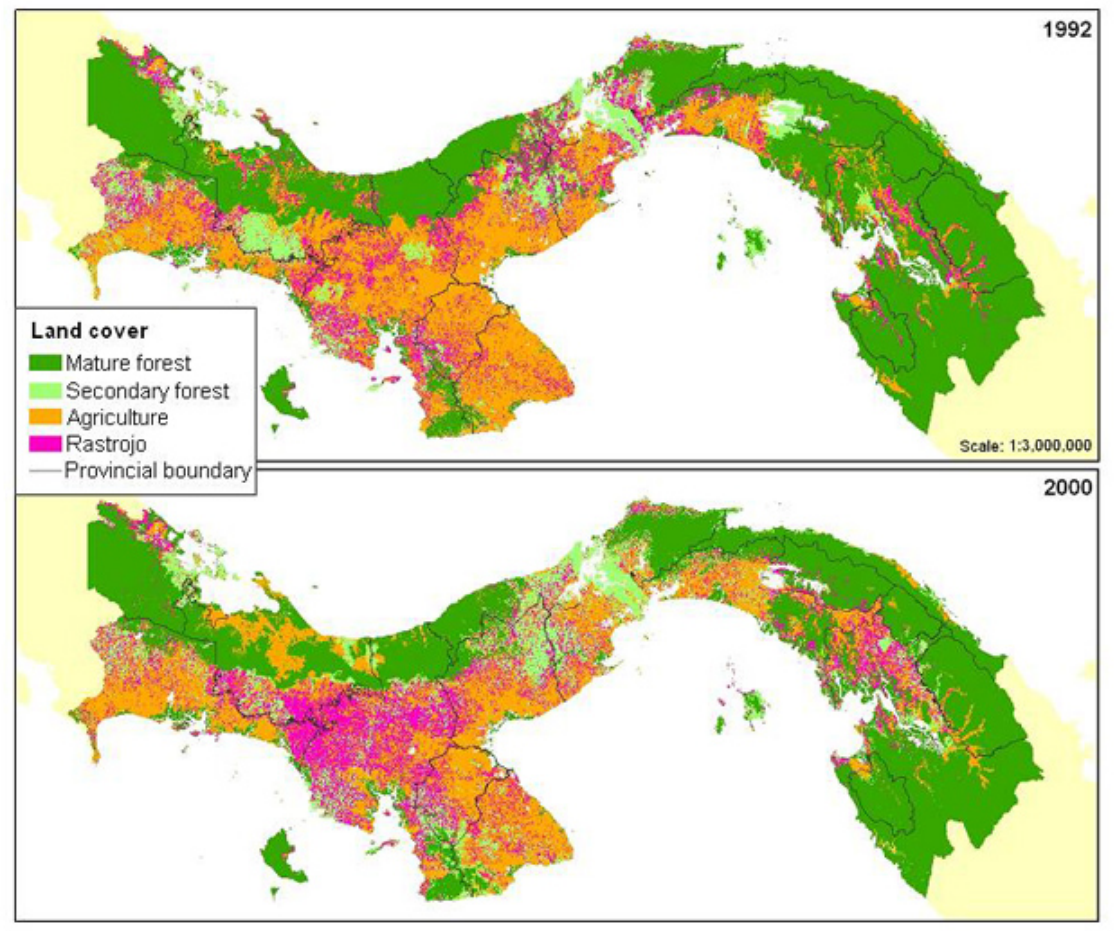
Fig. 2. Land-cover maps for 1992 and 2000 for the Republic of Panama. Land cover was determined from LandSat image analyses conducted by the Autoridad Nacional de Ambiente of the Republic